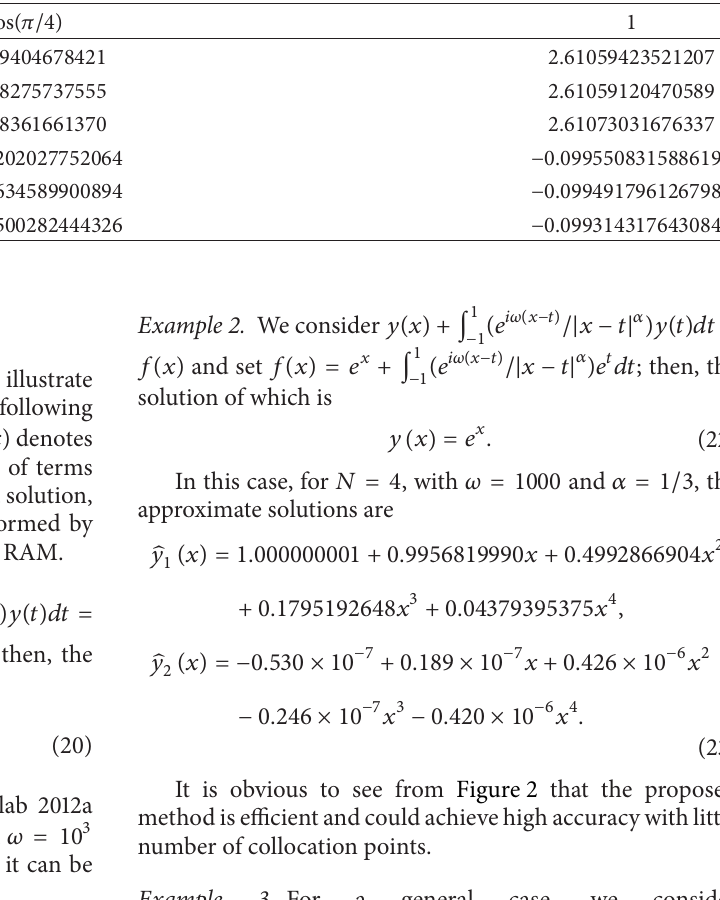
1 (𝑒 𝑖𝜔(𝑥−𝑡) /|𝑥 − 𝑡| 0.5 )𝑦(𝑡)𝑑𝑡 = 𝑒 𝑥 with 𝜔 = 10 3 −1